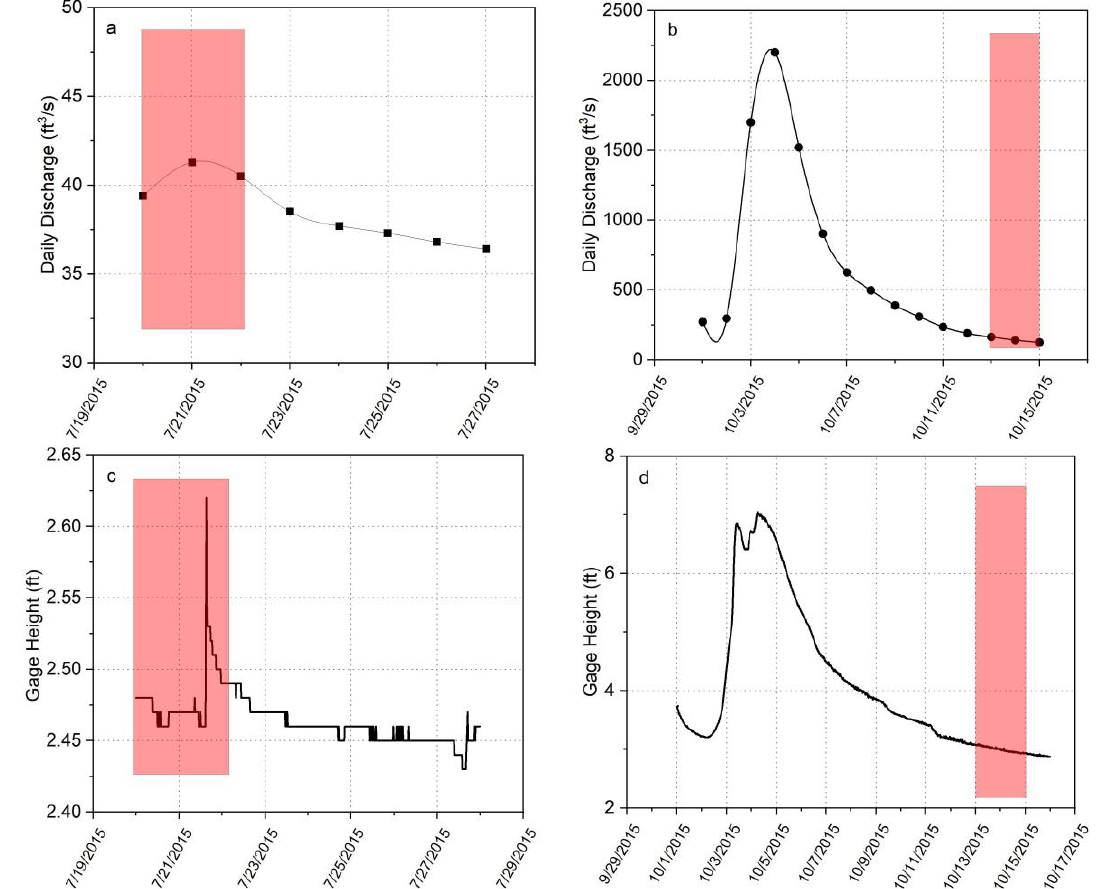
Figure 4. USGS stream flow and height data for South River in 2015: ( a ) stream flow during baseline condition (July 2015), ( b ) stre.am flow during drainage condition (October 2015), ( c ) stream height during baseline condition (July 2015), ( d ) stream height during drainage condition (October 2015).